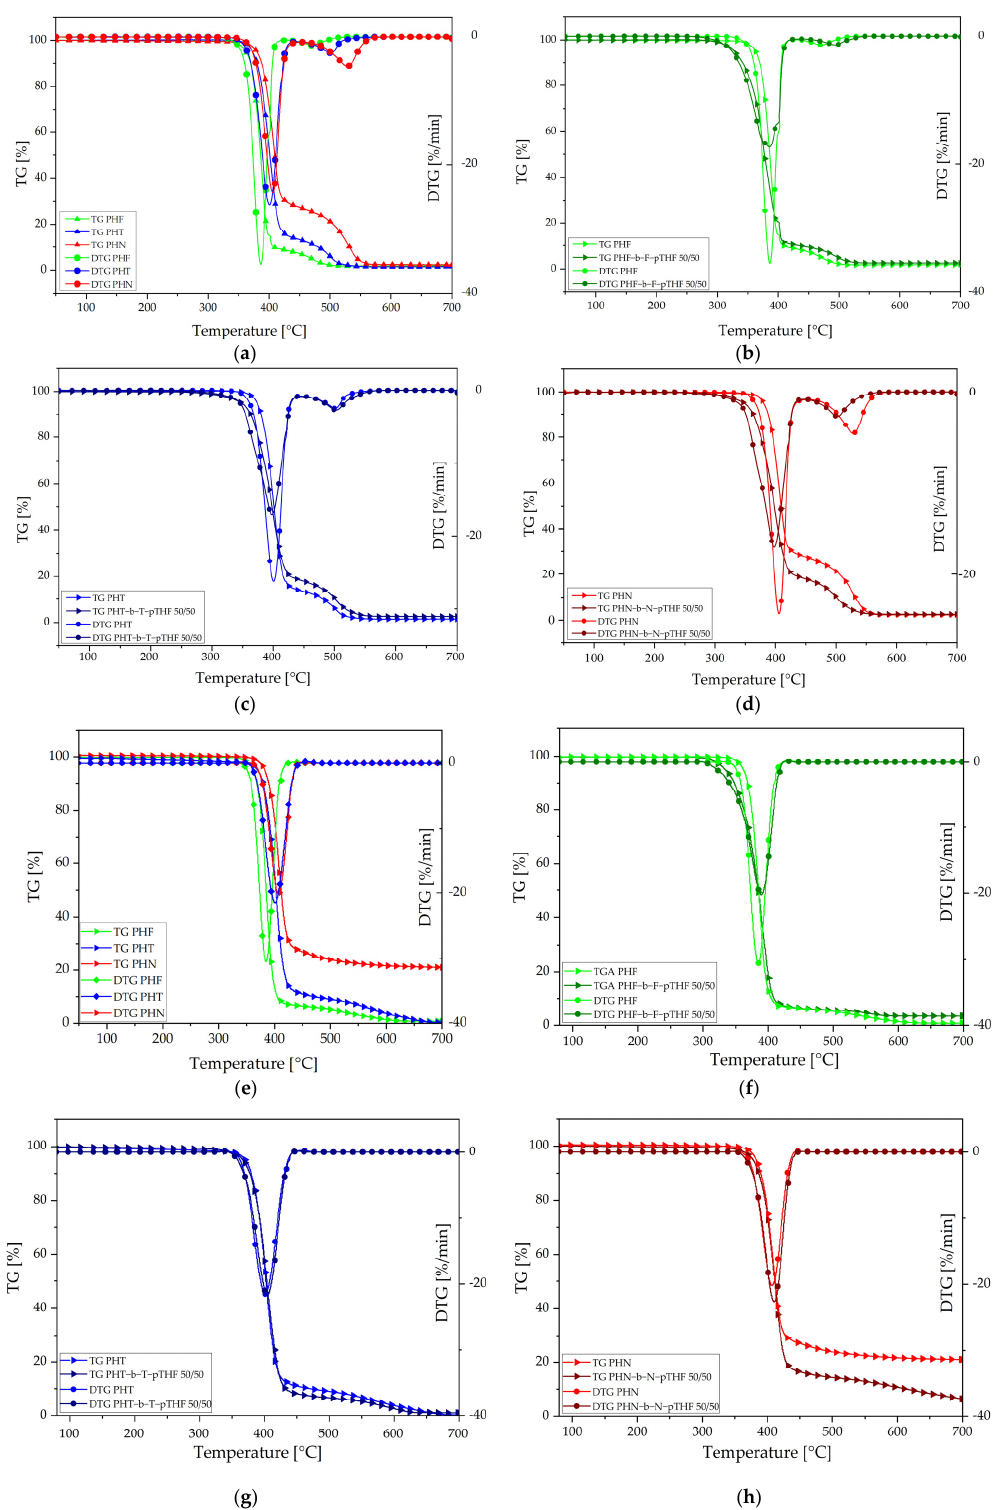
Figure 12. TG and DTG curves for synthesized materials measured in an oxidizing atmosphere ( a – d ) and in an inert atmosphere (argon) ( e – h ) at the heating rate of 10 °C/min.